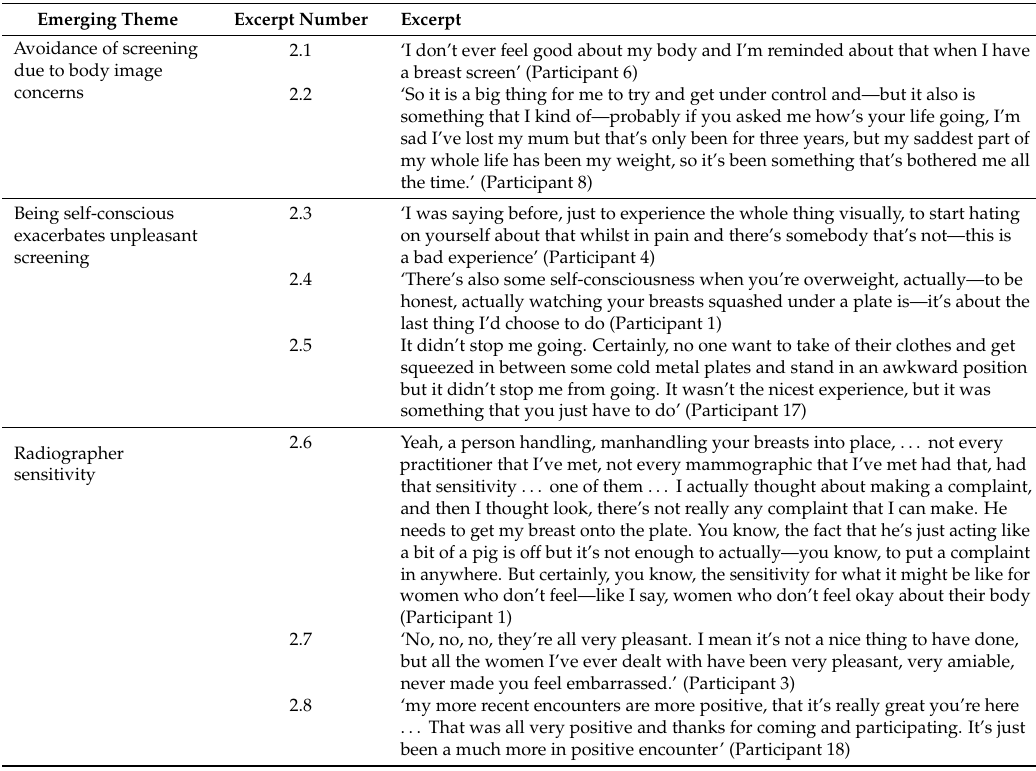
Table 4. Body image concerns impact on the screening experience for obese